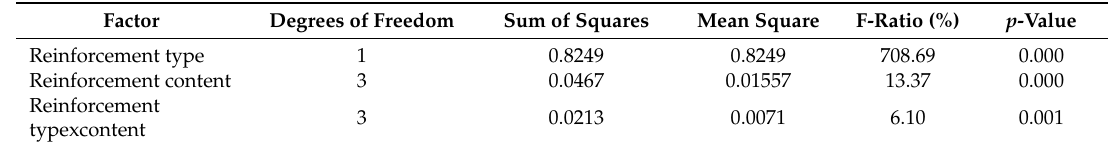
Figure 16. Main effect plot for differential shrinkage.